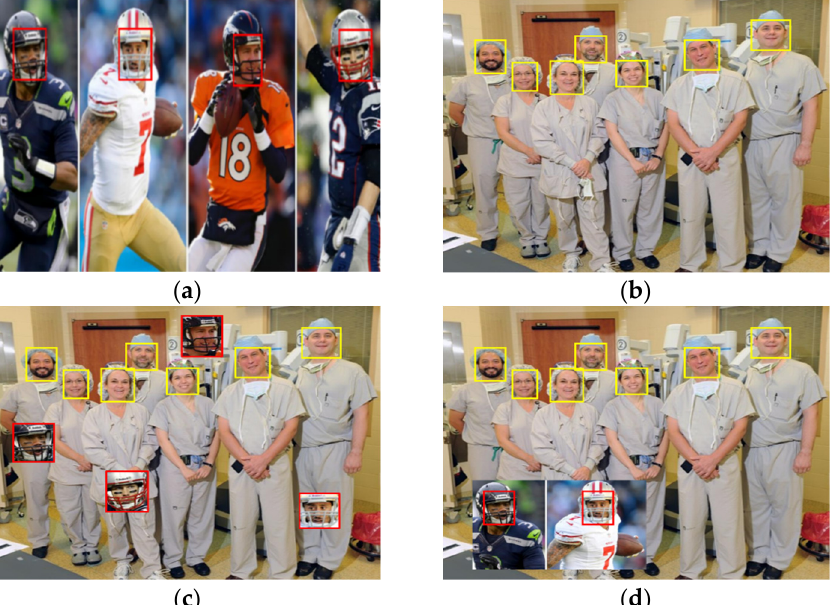
Figure 3. Copy-Paste methods for face images: ( a ) source (reference) image, ( b ) target (original) image, ( c ) pasted image with bounding box only, and ( d ) pasted image with the shoulder and neck as well as face.